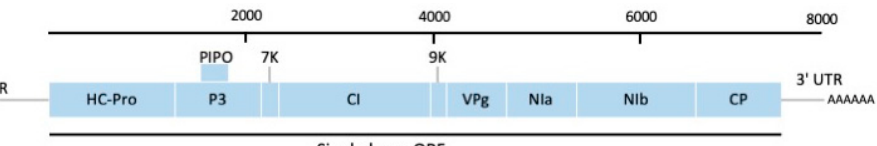
Figure 3. Schematic representation of species Chinese yam necrotic mosaic virus (CYNMV), genus Macluravirus genome, family Potyviridae . The 10 functional proteins represented are HC-Pro: helper component protease (gene silencing and vector transmission), P3: third protein (virus replication), 7K, CI: cylindrical inclusion protein (virus movement and replication), 9K, VPg: viral genome-linked protein (viral replication), NIa: major protease of small nuclear inclusion protein (polyprotein processing), NIb: large nuclear inclusion protein (RNA-dependent RNA polymerase), CP: coat protein (virus movement and virion formation) and PIPO: pretty-interesting-potyvirus-ORF (virus movement).